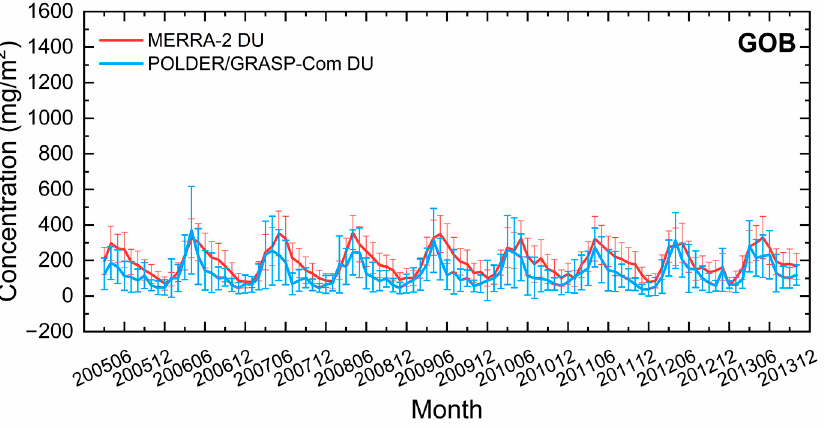
Figure 6 . Same as Figure 3, but for Taklamakan Desert (TAK) region. Figure 6. Same as Figure 3, but for Taklamakan Desert (TAK)